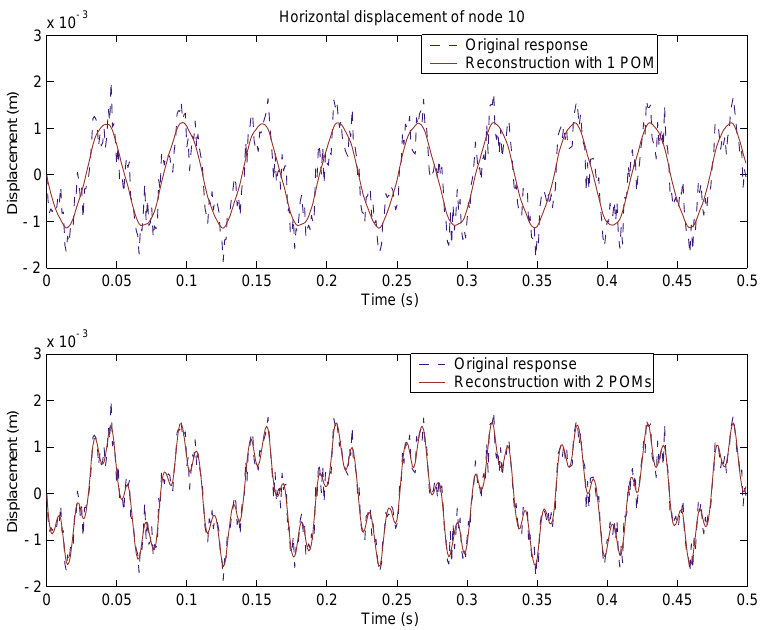
Fig. 5. Dynamics reconstruction of the horizontal displacement at node 10 for a vertical impulse applied at the same